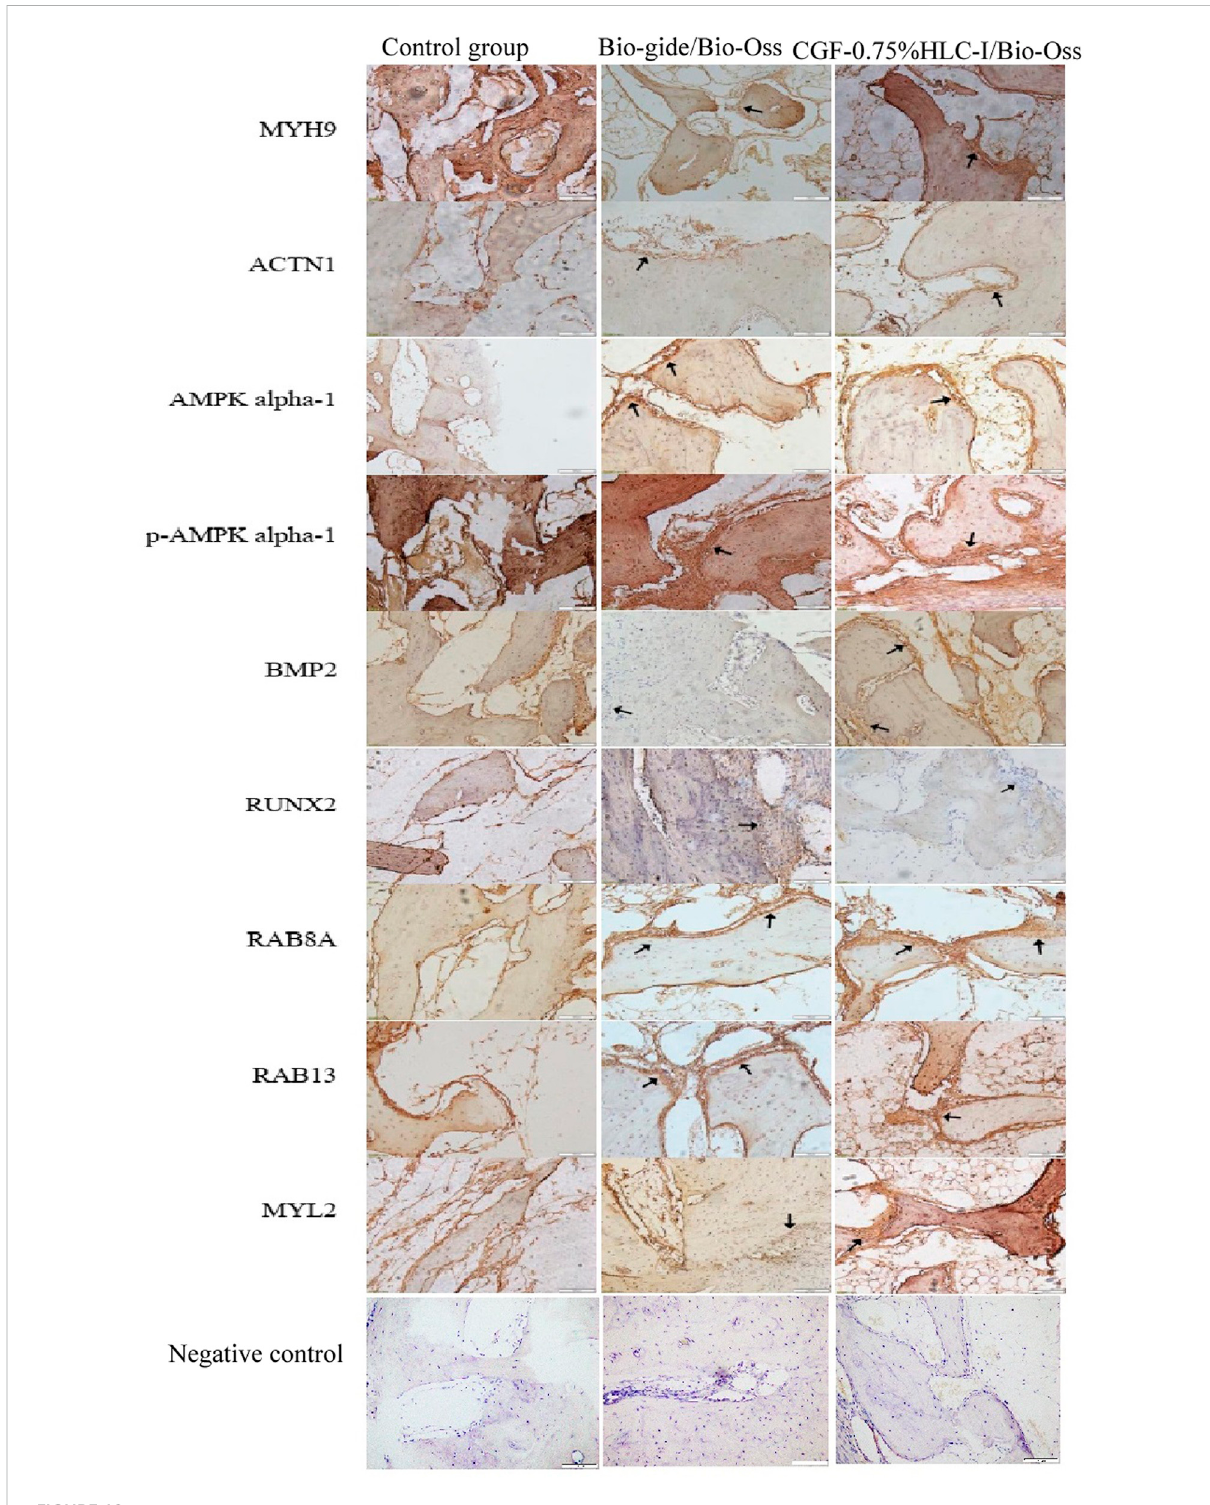
FIGURE 10 The immunohistochemical staining of tissues (arrow shows osteoblasts) (SP,